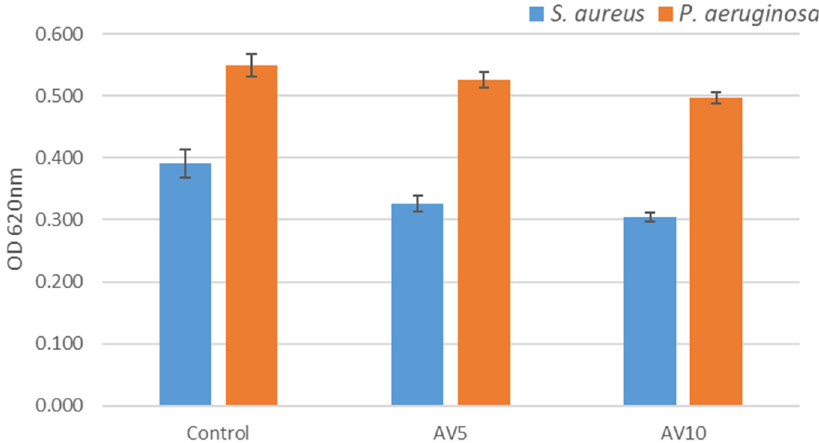
Figure 4. The effect of the two types of hydrogels on the bacterial growth at 24 h. Results are shown as mean ± deviation standard, n =